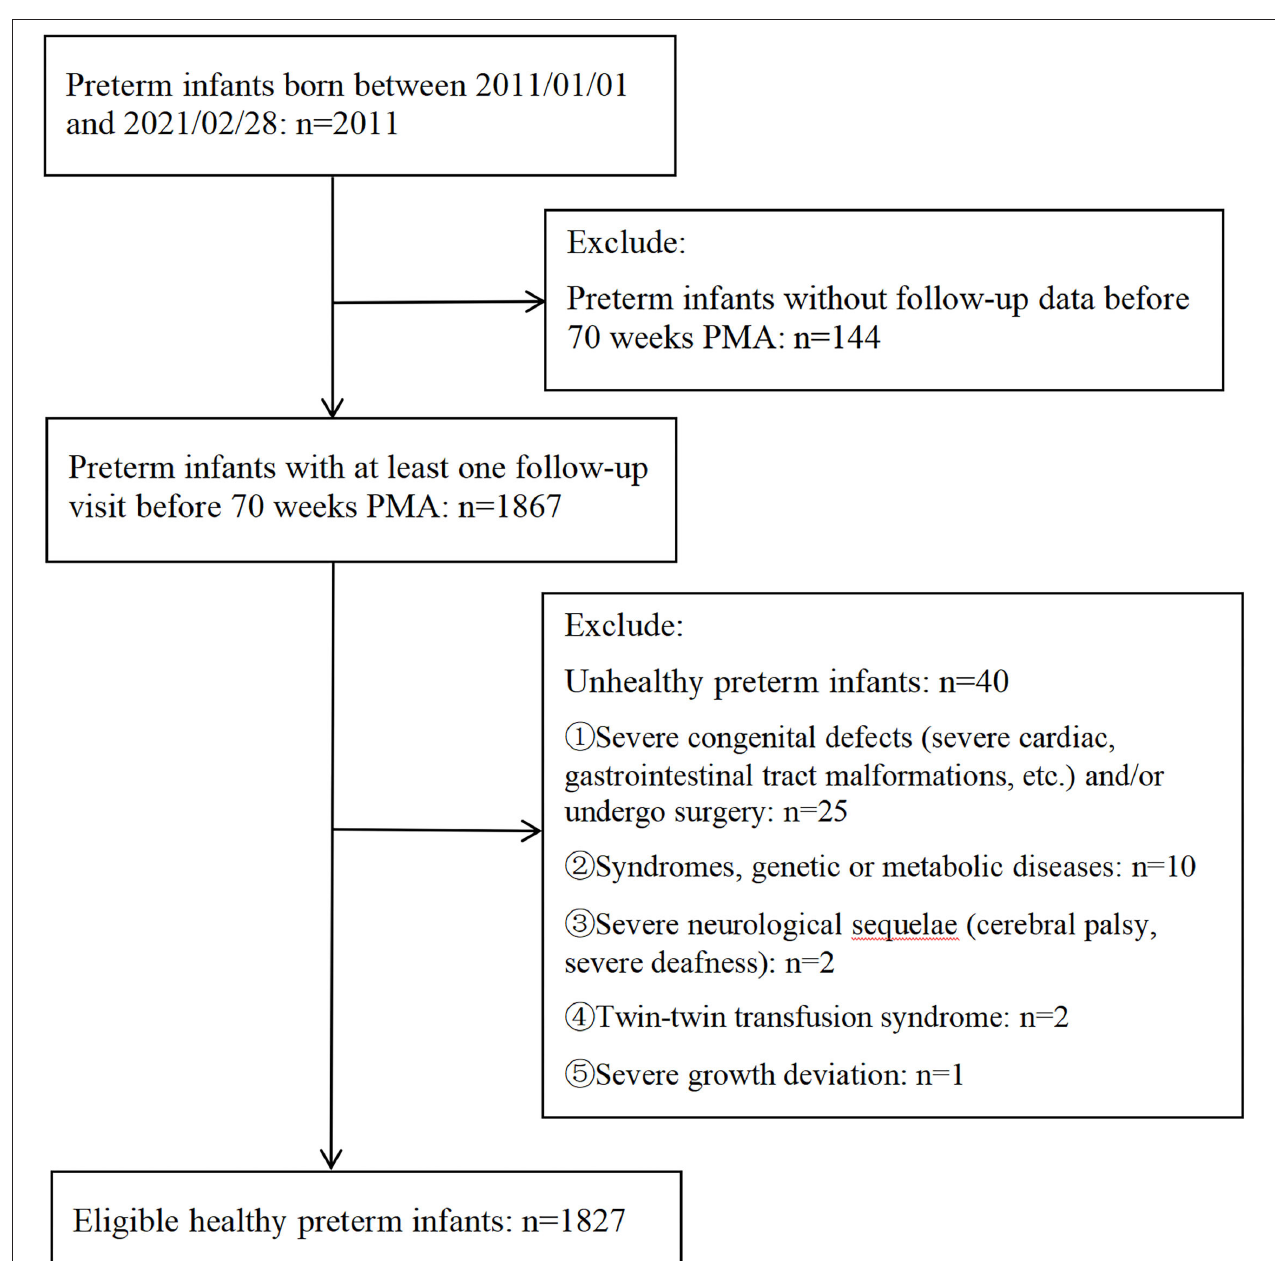
FIGURE 1 | Flowcharts of sampling eligible healthy preterm infants. Severe growth deviation in this study was identified as the difference between the Z -scores of two adjacent measurements > + 2 or < -2 according to the Fenton reference (before 40 weeks of PMA) and WHO growth standards (40 weeks of PMA and beyond). PMA, postmenstrual